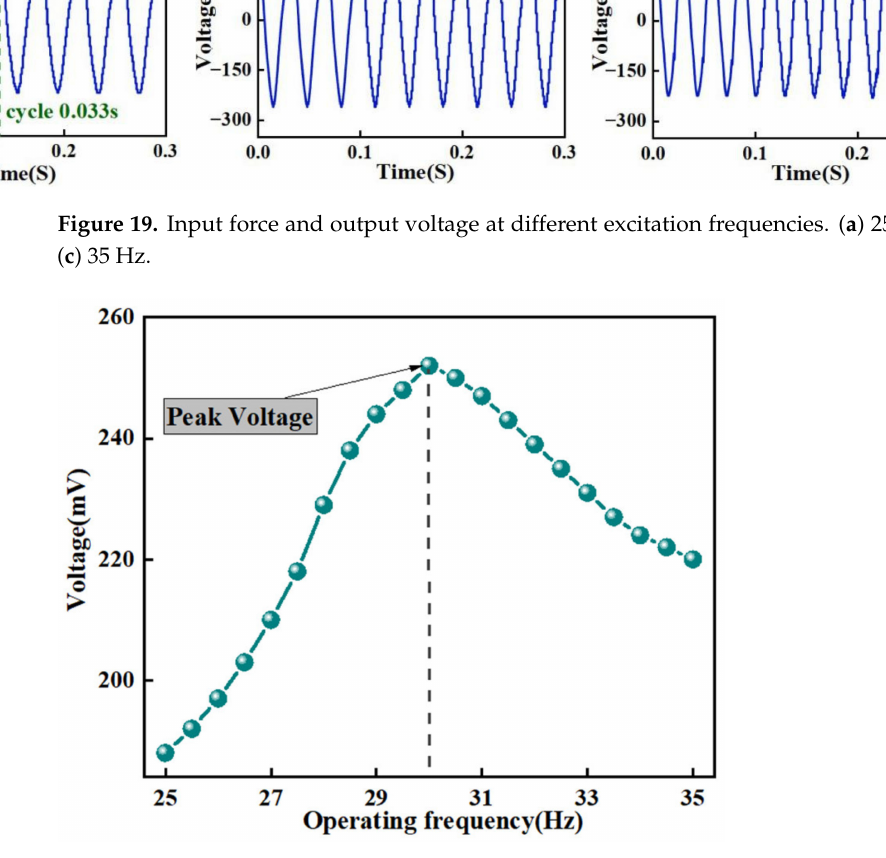
Figure 20. Output voltage of the harvesting device at 25–35 Hz operating